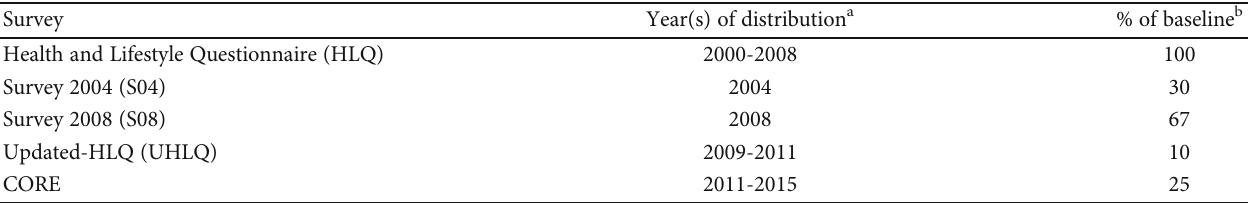
Table 1: Percentage of Alberta ’ s Tomorrow Project Health and Lifestyle Questionnaire Survey (baseline) participants that responded to each follow-up survey.